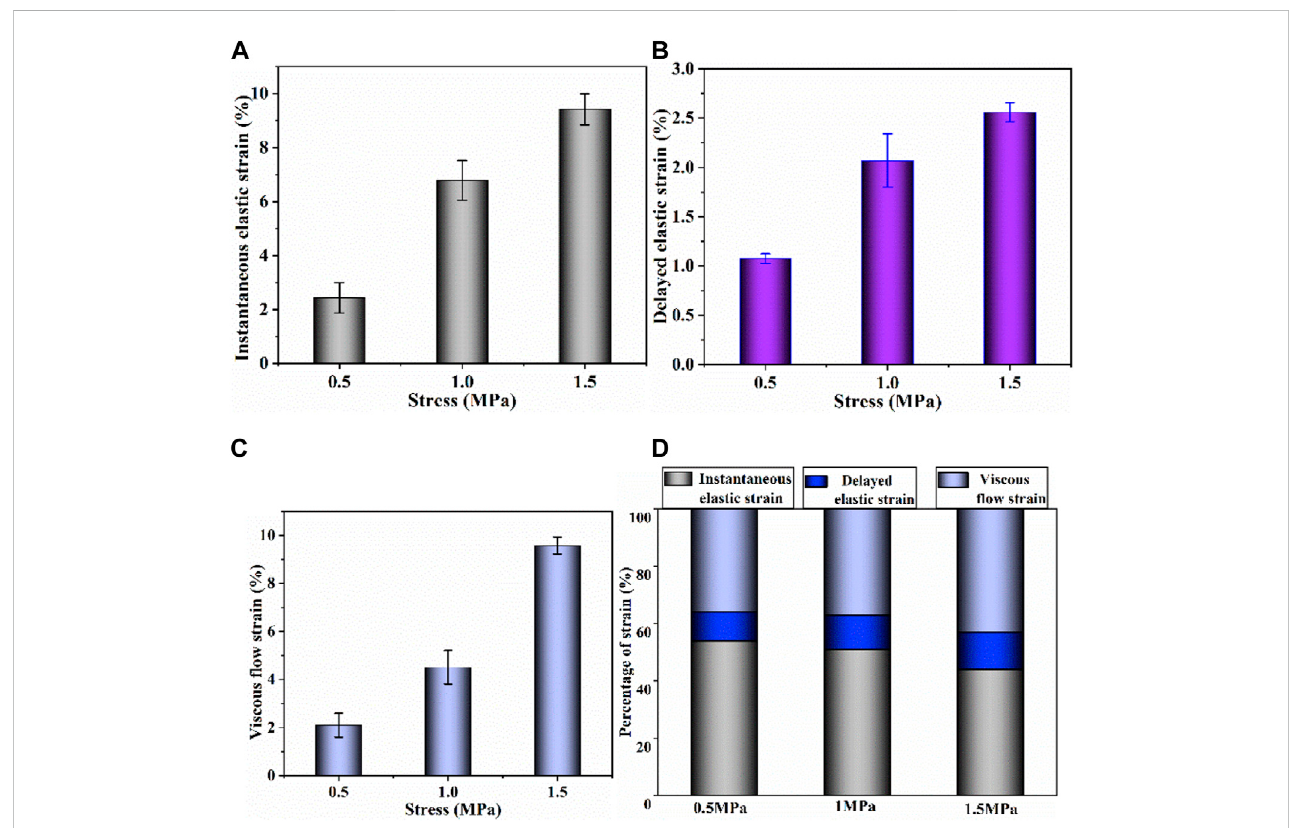
FIGURE 7 (A – C) Instantaneous elastic strain, delayed elastic strain and viscous fl ow strain components of biaxial creep strain, respectively; (D) percentage of each biaxial strain component at different stress levels.